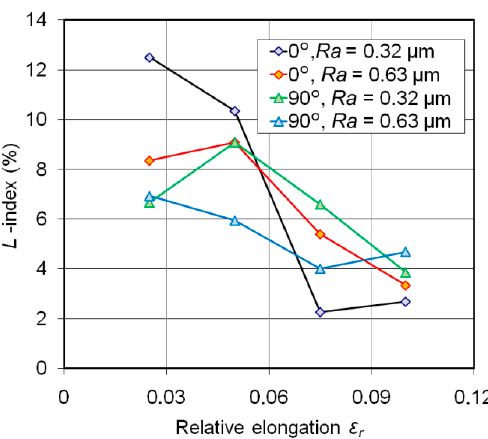
Figure 7. Effect of the relative elongation ε r on the effectiveness of lubrication.